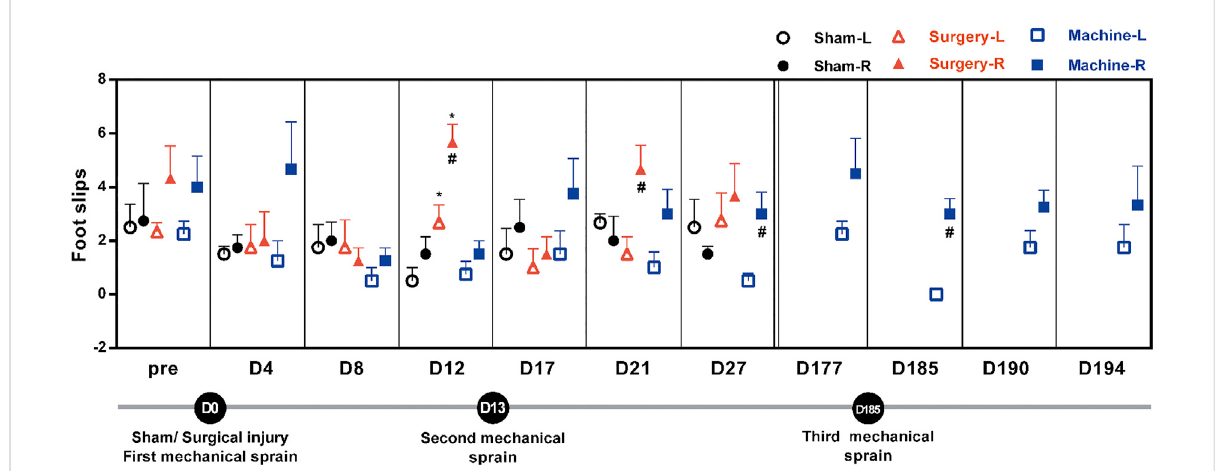
FIGURE 4 Effect of mechanical ankle sprains on motor balance and coordination. The number of hind foot slips were measured using a beam test on the indicateddaytoevaluatemotorbalanceandcoordinationaftershamoperation,CFLtransection,andthreemechanicalsprains.Totalnumberoffoot slips were counted in three tests at each time point. Values are mean ± SEM, n = 4. # p < 0.05 compared with corresponding left untreated foot (L) using paired t test. * p < 0.05 compared with sham operation group using unpaired t